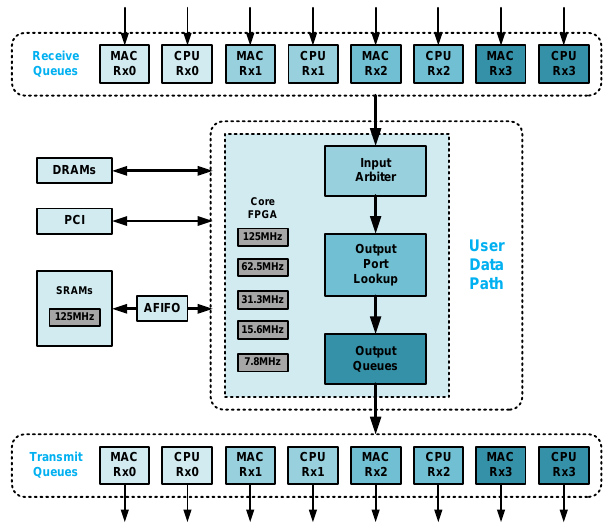
Figure 2. The architecture of the frequency-scaled